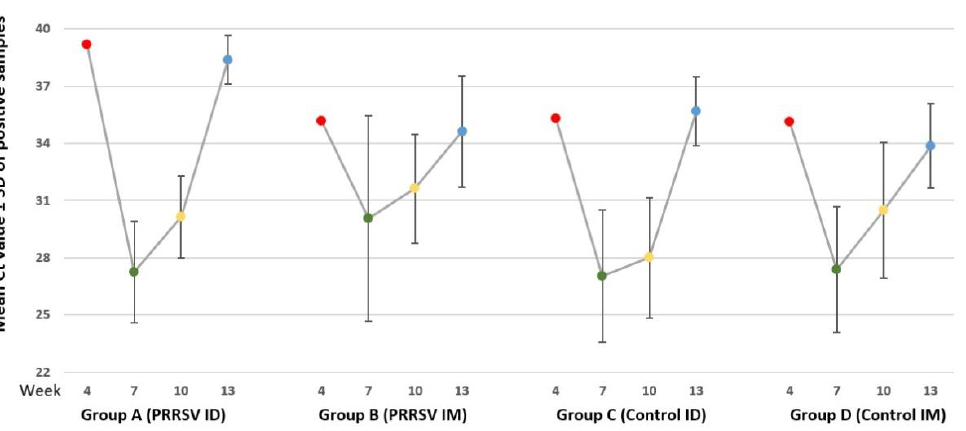
Figure 2. Ct values (mean ± SD) of qRT-PCR in serum samples at 4, 7, 10, and 13 weeks of age.